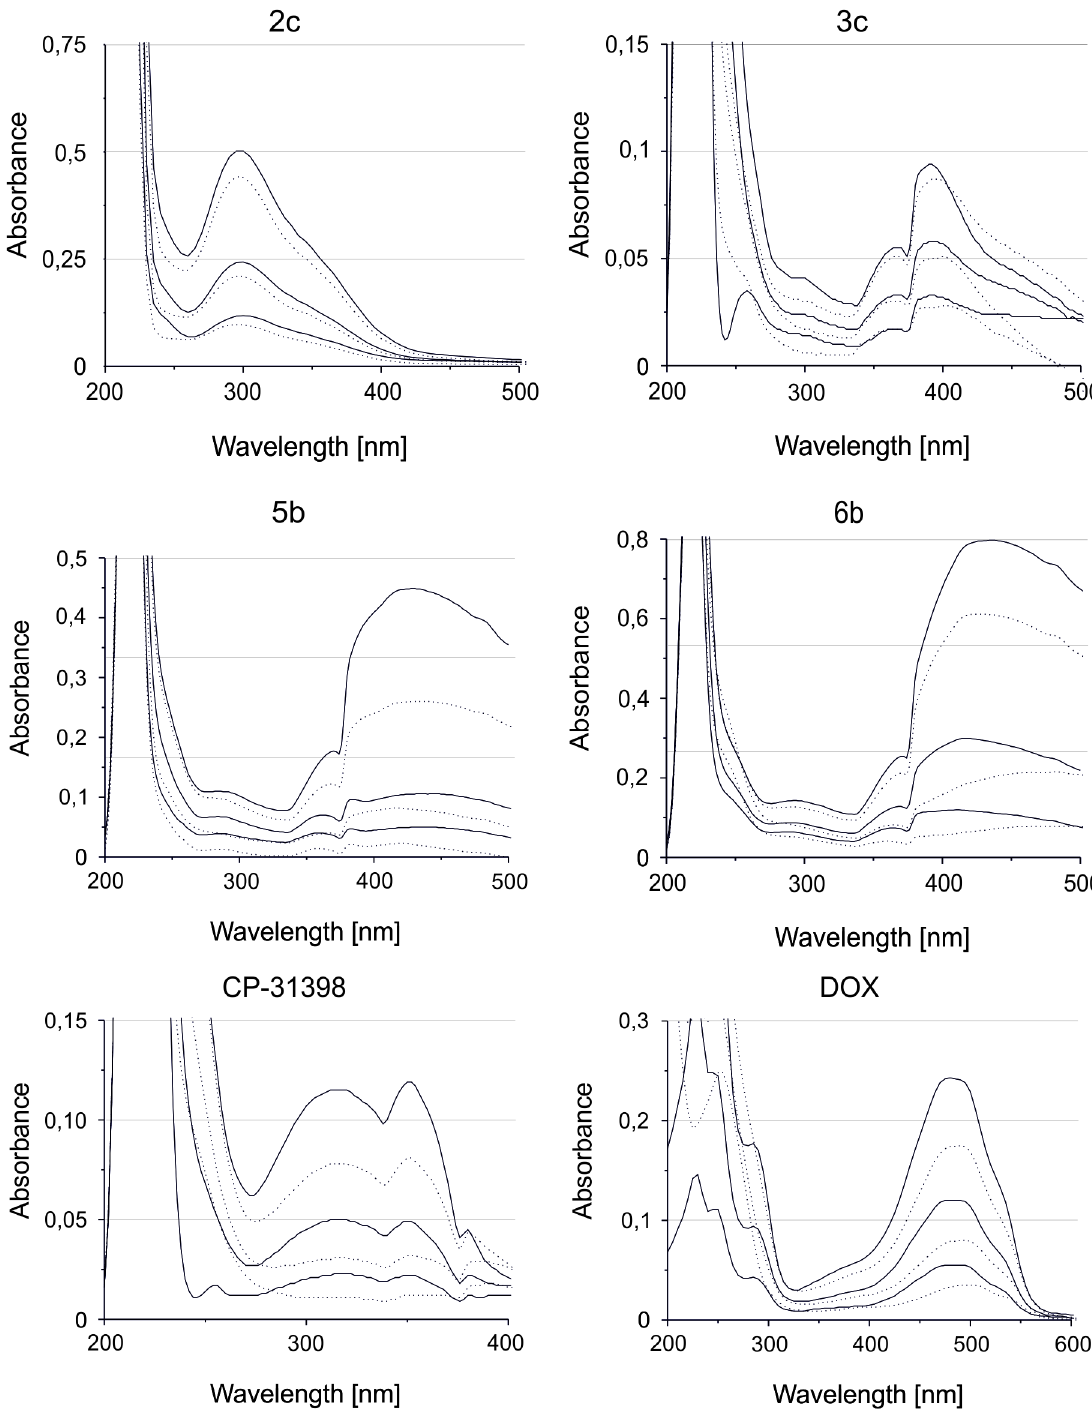
Fig 8. Absorption spectra of 2c, 3c, 5b, 6b, CP-31398 and doxorubicin without CT-DNA (solid line) and with CT-DNA (dotted line).